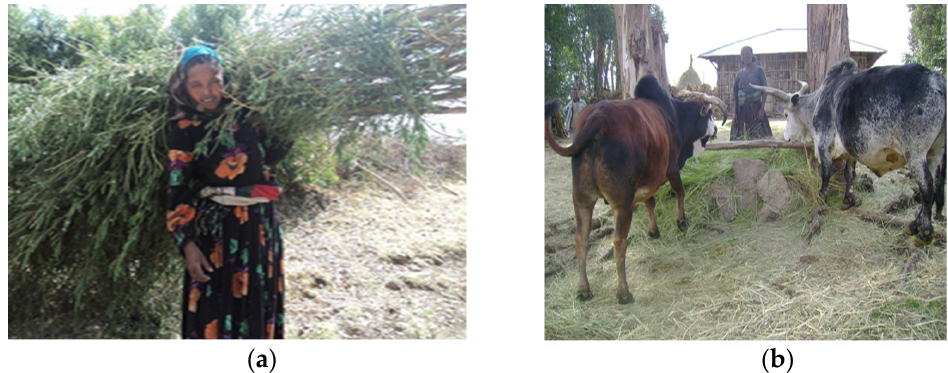
Figure 10. Photograph showing animal fattening activities: ( a ) a female farmer carrying fodder; and ( b ) a female farmer feeding fattening animals.